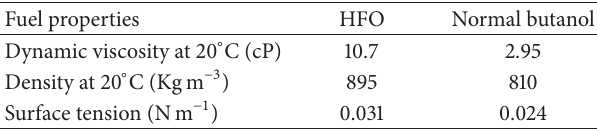
Blobs/ligaments/ droplets